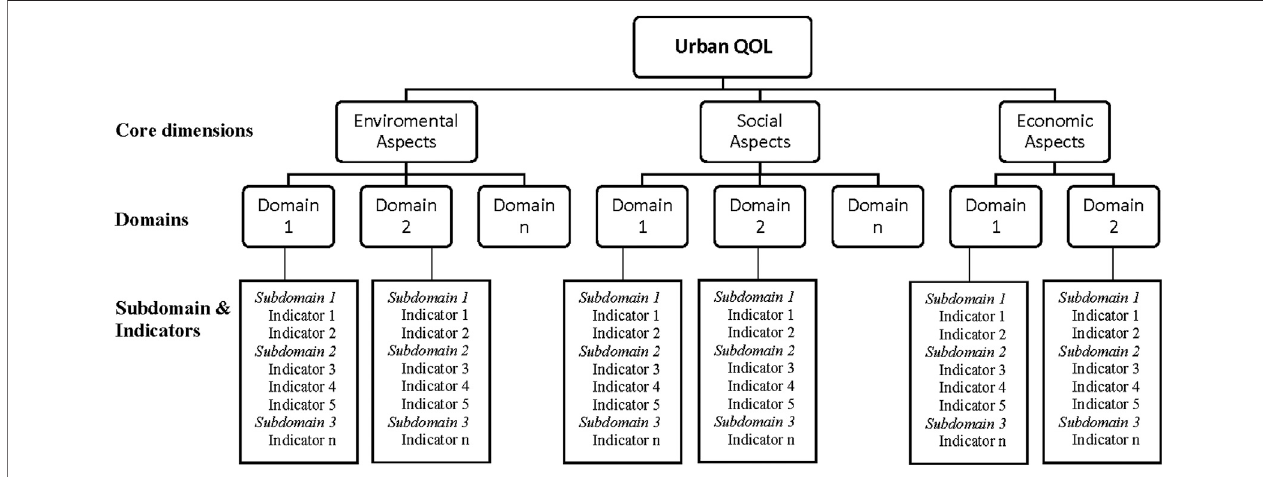
FIGURE 2 | Conceptual framework of an urban QOL assessment